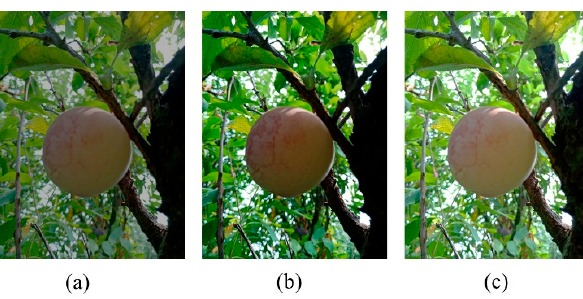
Figure 3. ( a ) Low-brightness, ( b ) medium-brightness, and ( c ) high-brightness images.